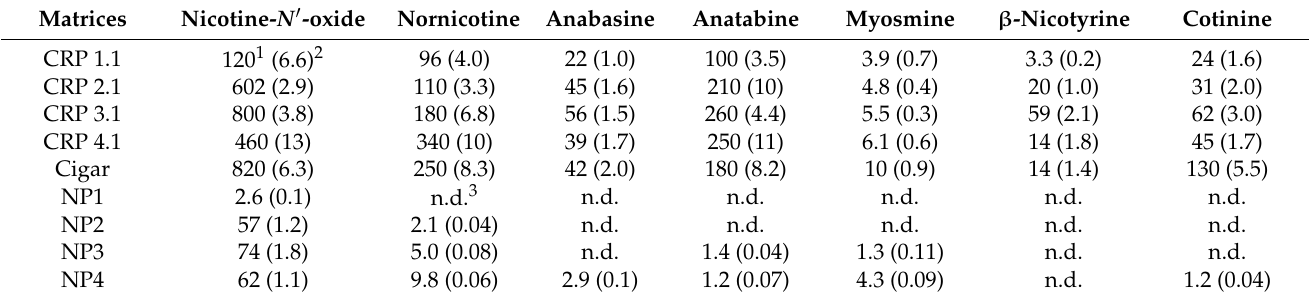
Table 9. Determined concentrations ( µ g/g) of the analytes (n = 3) in the different matrices.